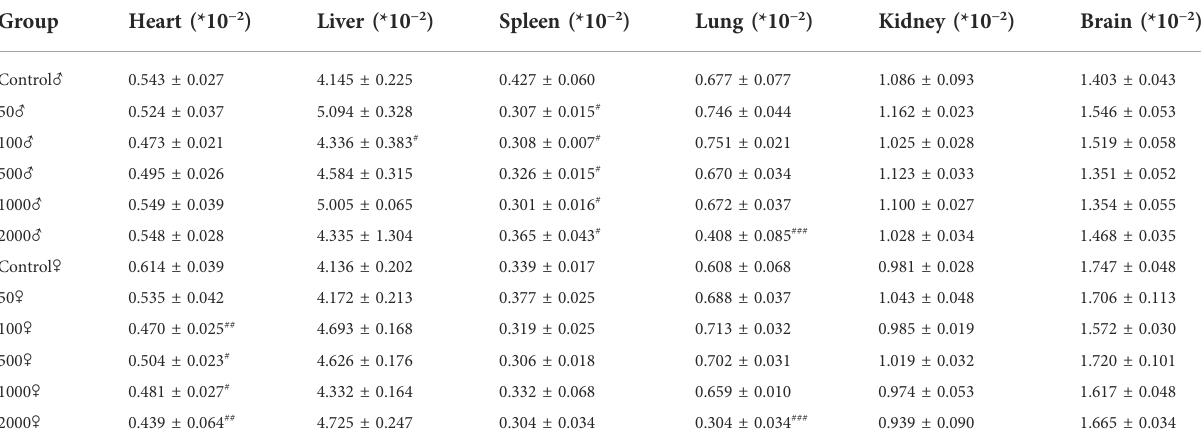
TABLE 3 Effect of NAY on organ coef fi cient in